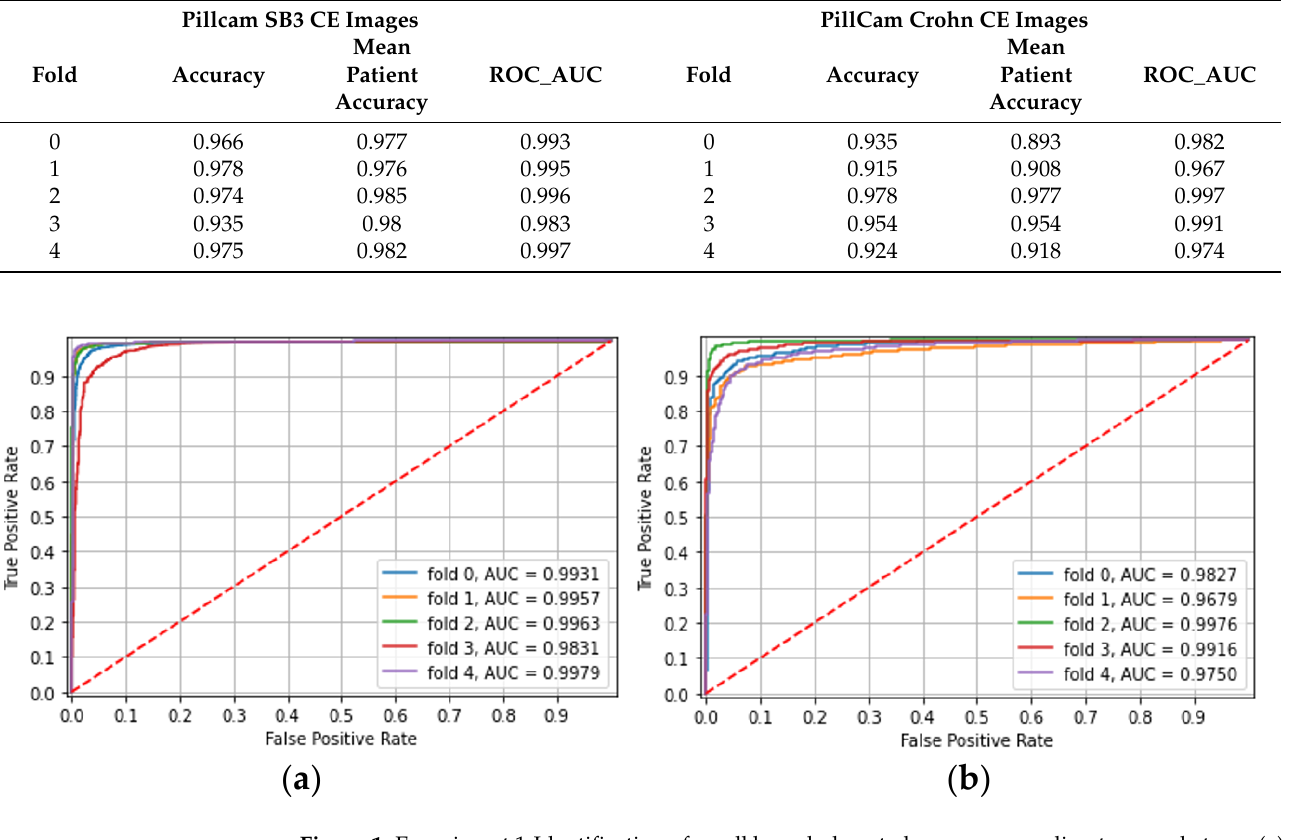
Table 2. Experiment 1-Identification of small bowel ulcerated mucosa according to capsule type.